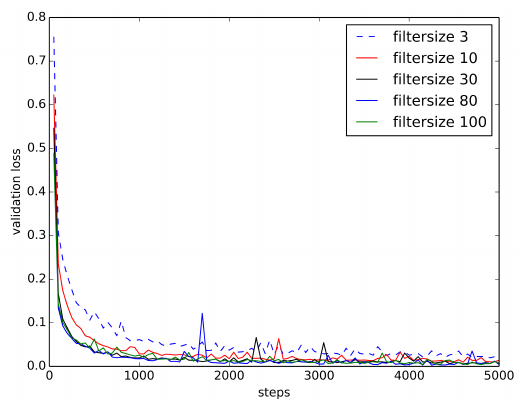
Figure 9. Loss Curves of RawConvNet on BUZZ1 Train/Test Dataset. As the size of the receptive field increases, loss curves become smoother and decrease faster.